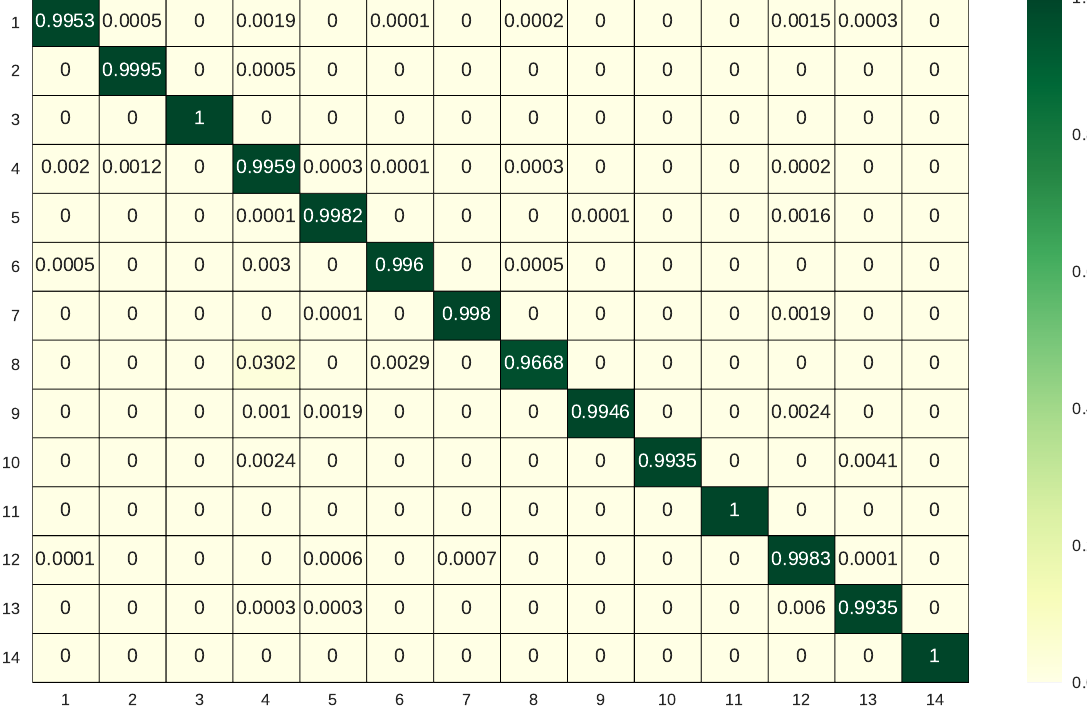
Figure 16. Classification confusion matrix for Flevoland Benchmark data set by using BSLGDA + FCN.